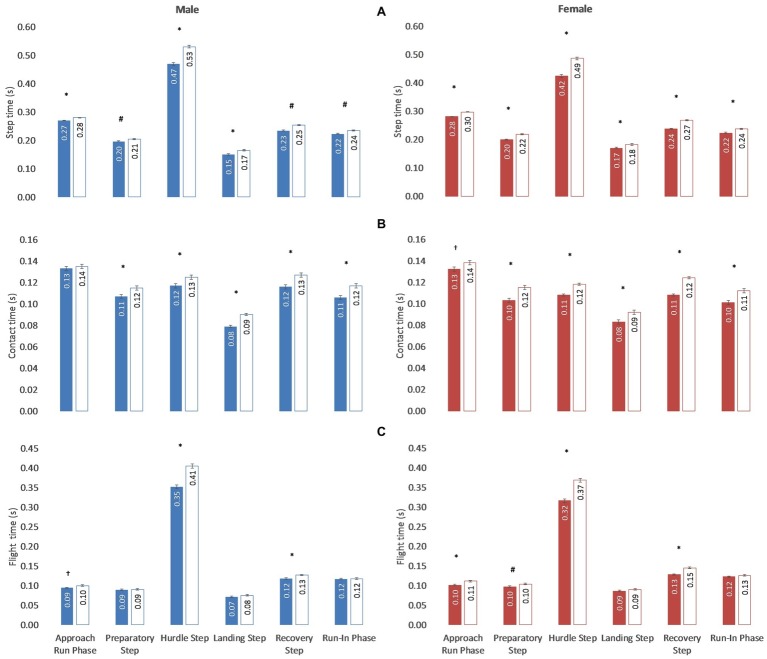
Step (A), contact (B) and flight (C) times (s) in the race phases of the elite-level (colored) and high-level (white) athletes (men and women) participating in the 44th Spanish Indoor and 12th IAAF World Indoor Championships. Statistical inter-level differences: †p < 0.05; #p < 0.01; *p < 0.001.